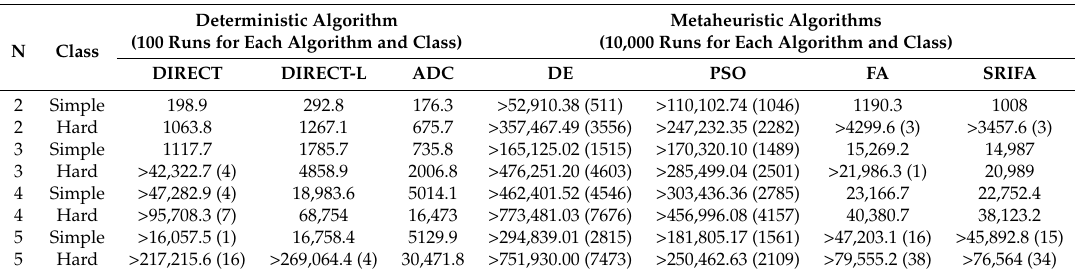
Statistical results obtained by deterministic and metaheuristic algorithms using GKLS generator.